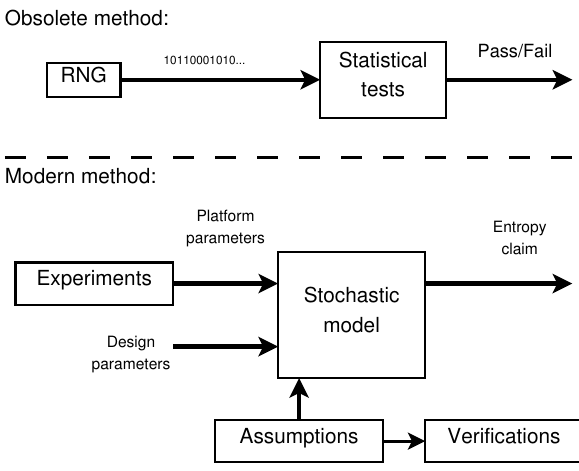
Figure 1: TRNG Design